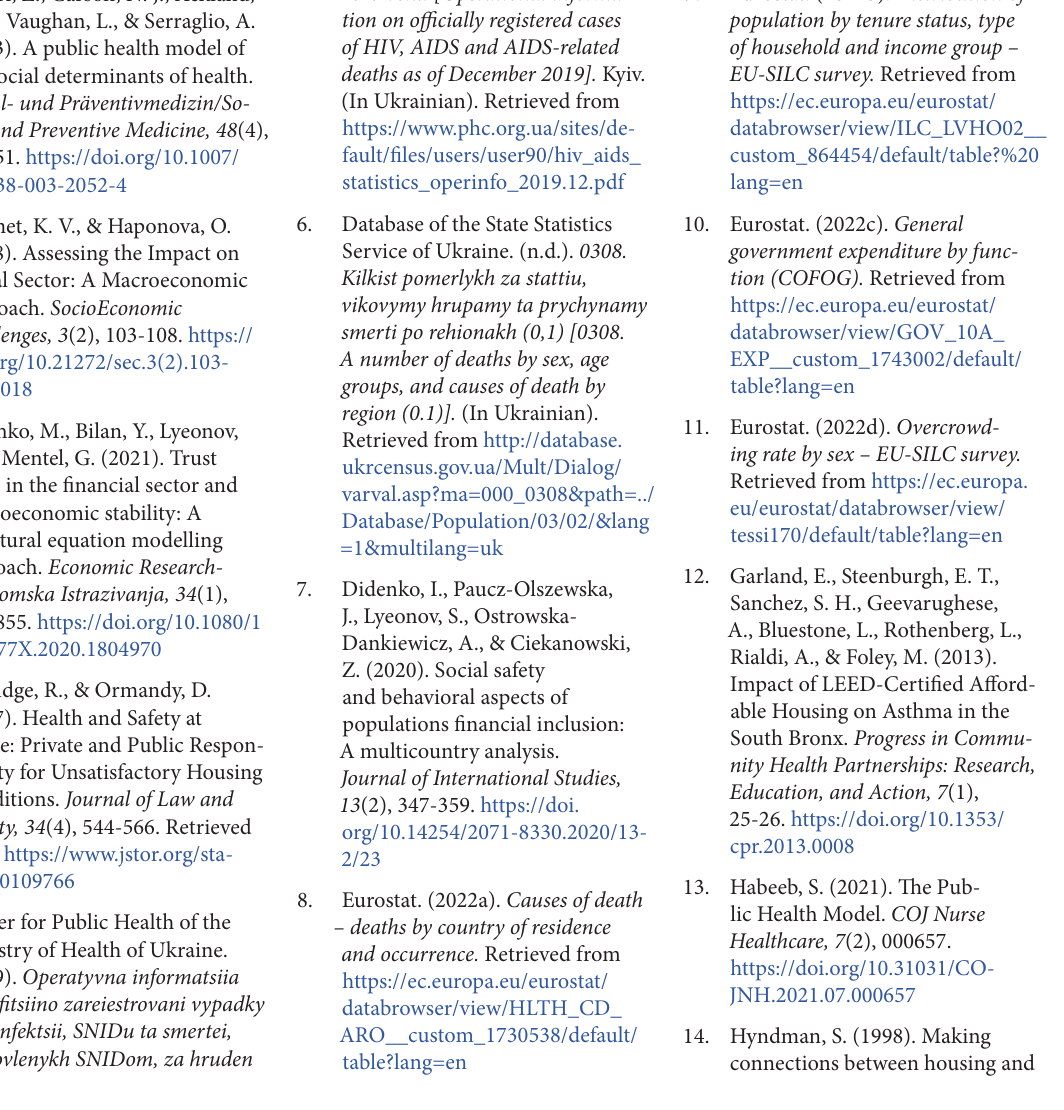
11. Eurostat. (2022d). Overcrowd- ing rate by sex – EU-SILC